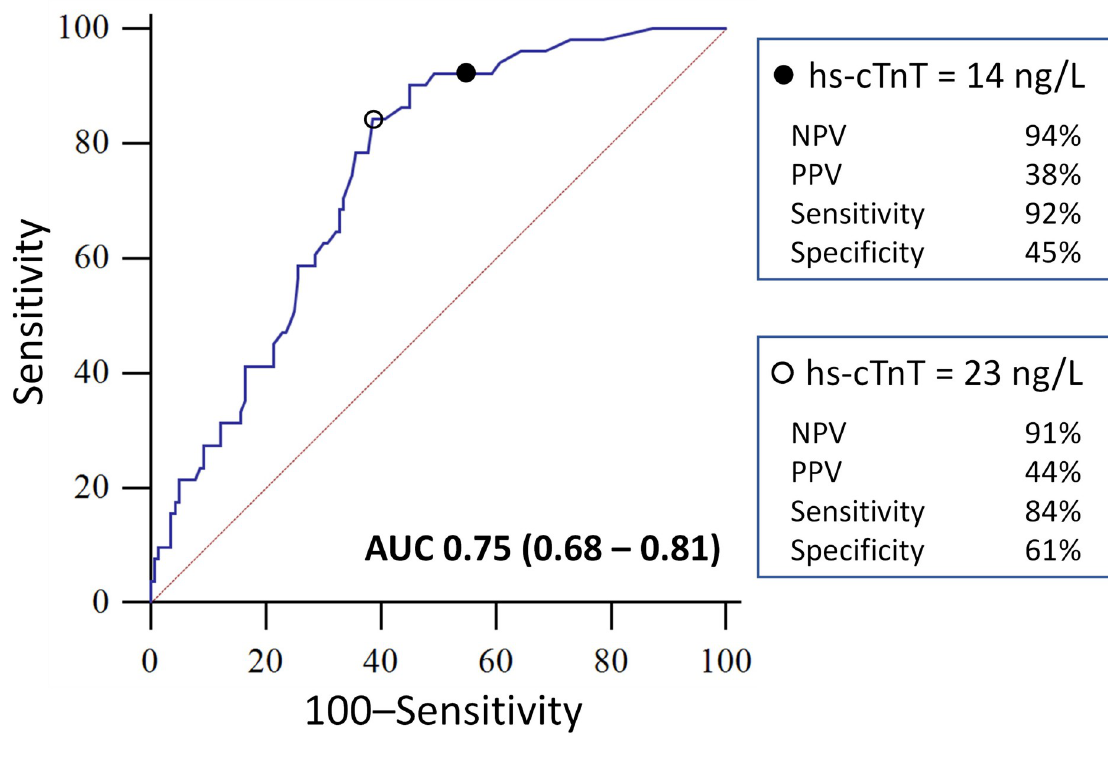
Fig 3. Receiver-Operating Characteristic (ROC) curve of the diagnostic performance of high sensitivity cardiac troponin T (hs-cTnT) for predicting inpatient mortality in patients with coronavirus disease 19 (COVID-19). A total of 191 patients were included in the ROC analysis. The hs-cTnT threshold of 14 ng/L was based on the 99 th percentile of healthy individuals (denoted by the filled dot in the top panel). The hs-cTnT threshold of 23 ng/L was based on the Youden point of the ROC curve (denoted by the empty dot in the bottom panel). AUC denotes area under the ROC curve; values in brackets denote the 95% confidence interval for the AUC with p value < 0.0001.